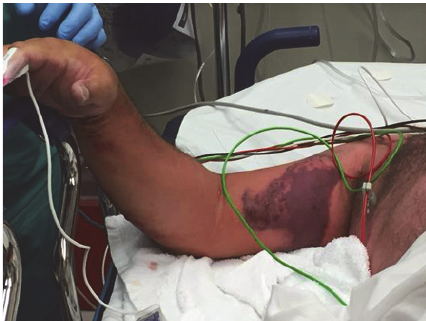
Figure 1: Right upper extremity on the day of presentation.